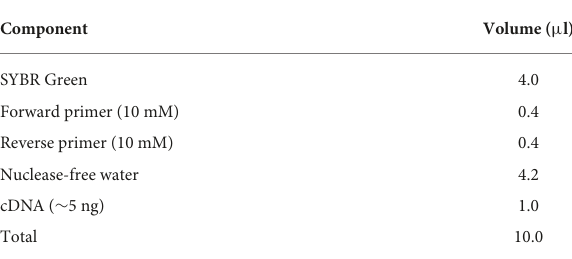
TABLE 1 Composition of the qRT–PCR reaction